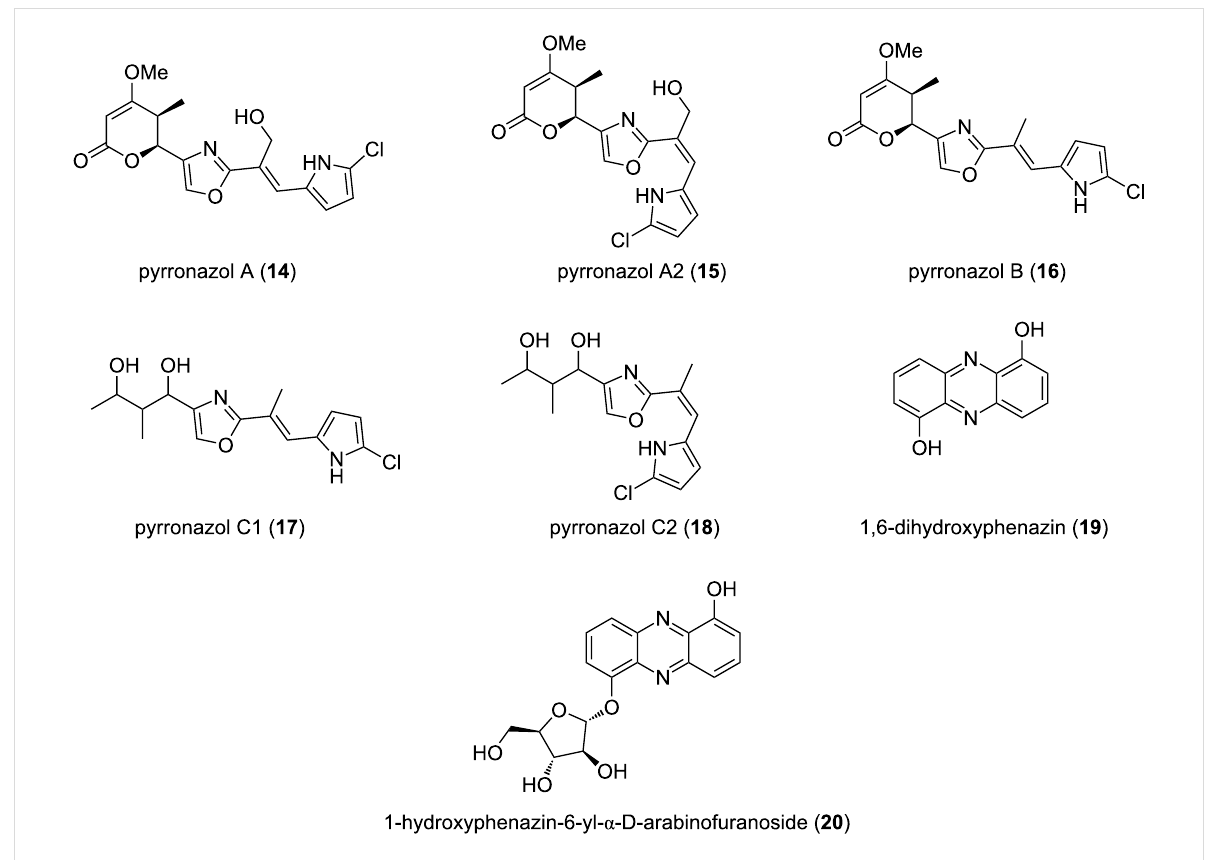
Figure 8: Structures of the pyrronazols, dihydroxyphenazin and 1-hydroxyphenazin-6-yl- α -D-arabinofuranoside.